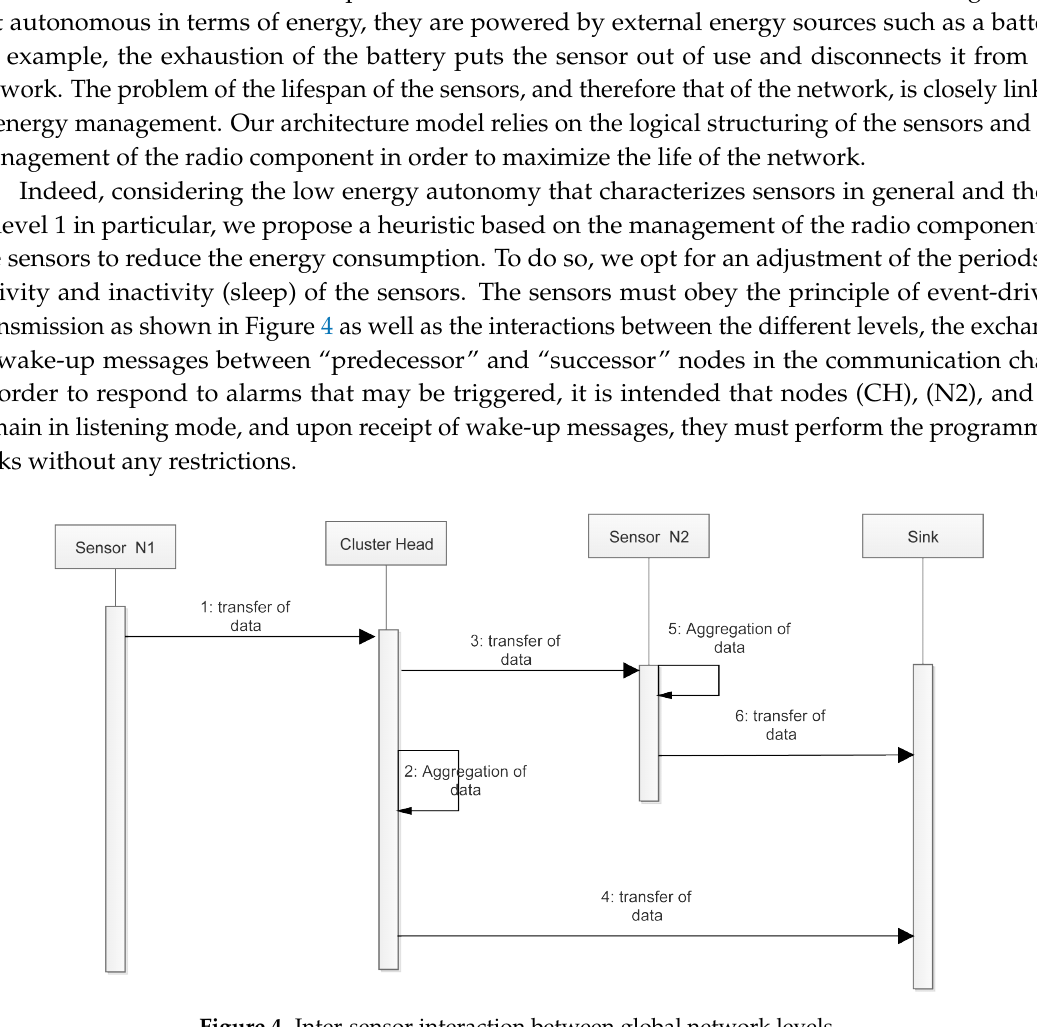
Figure 4. Inter-sensor interaction between global network